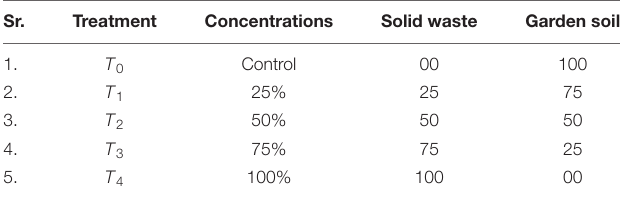
TABLE 1 | Preparation of various waste/soil mixtures for treatments. Sr.